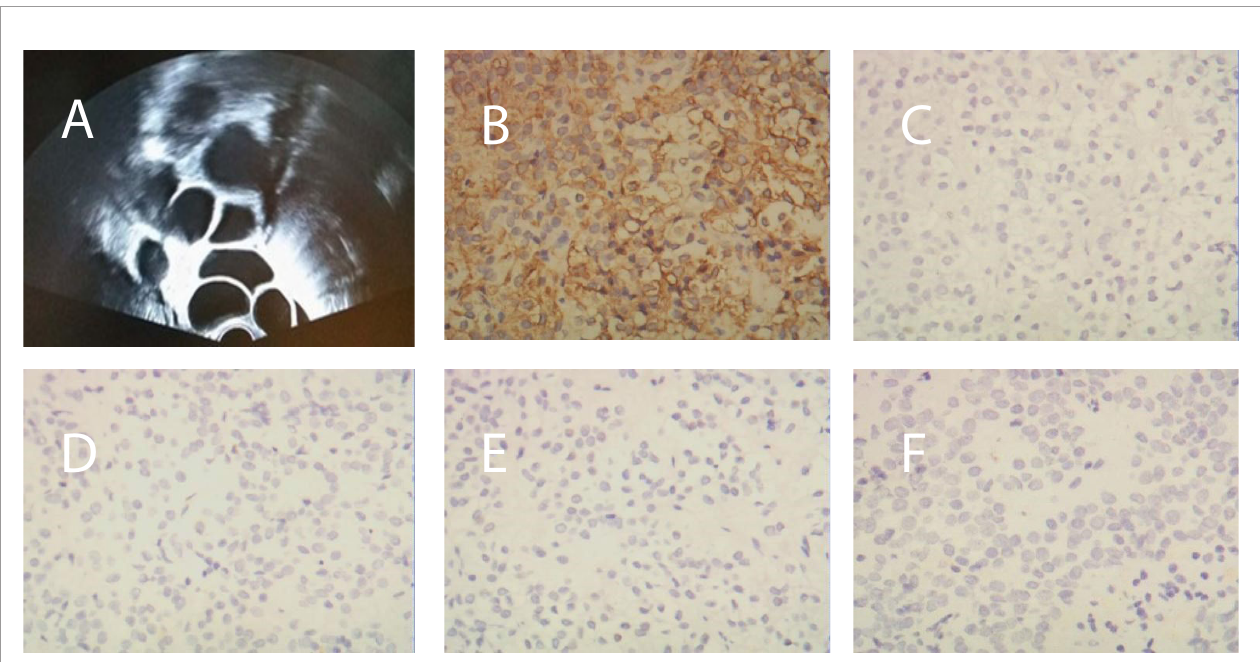
FIGURE 1 | (A) Transvaginal ultrasonography before surgery revealed bilaterally enlarged ovaries with multiple follicles. (B) Immunohistochemical staining of the pituitary adenoma for FSH, (C) GH, (D) LH, (E) PRL, and (F)